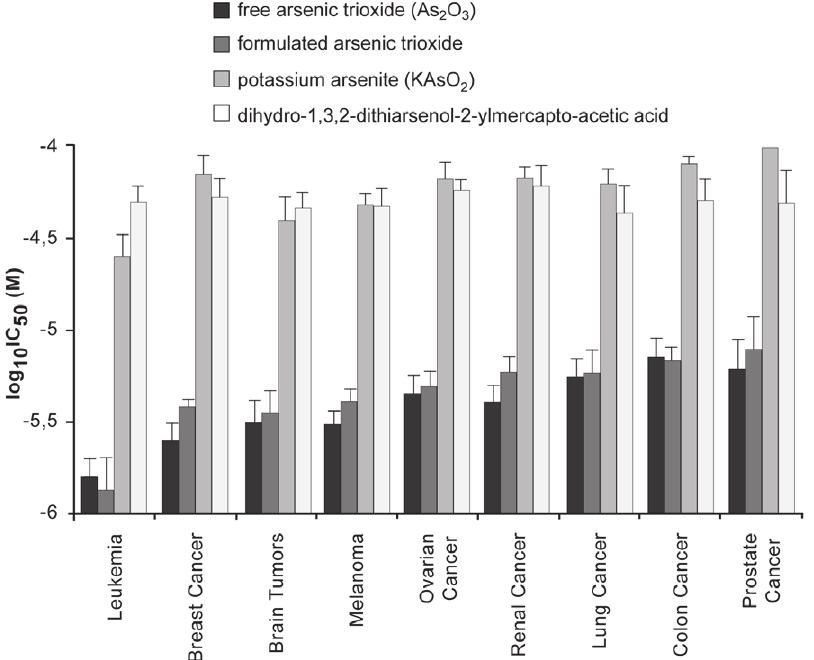
Figure 2. IC 50 values of four arsenicals for the NCI cell line panel. Mean values and SEM of IC 50 are grouped according to the tumor origin of the cell lines.